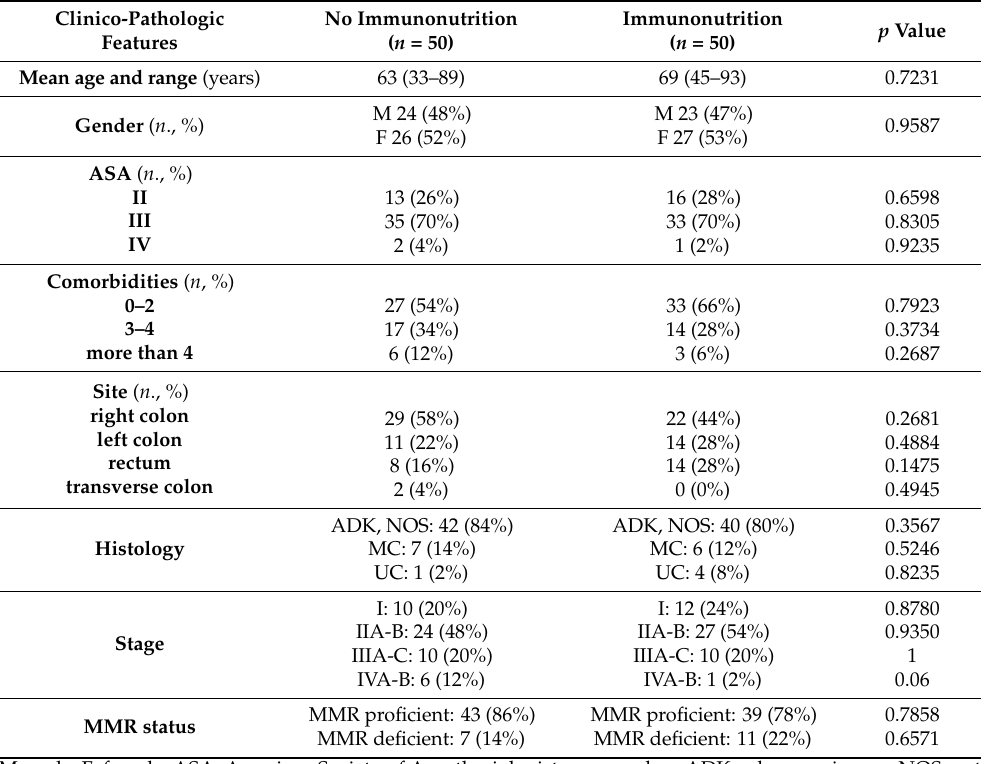
Table 1. Main features of the population under